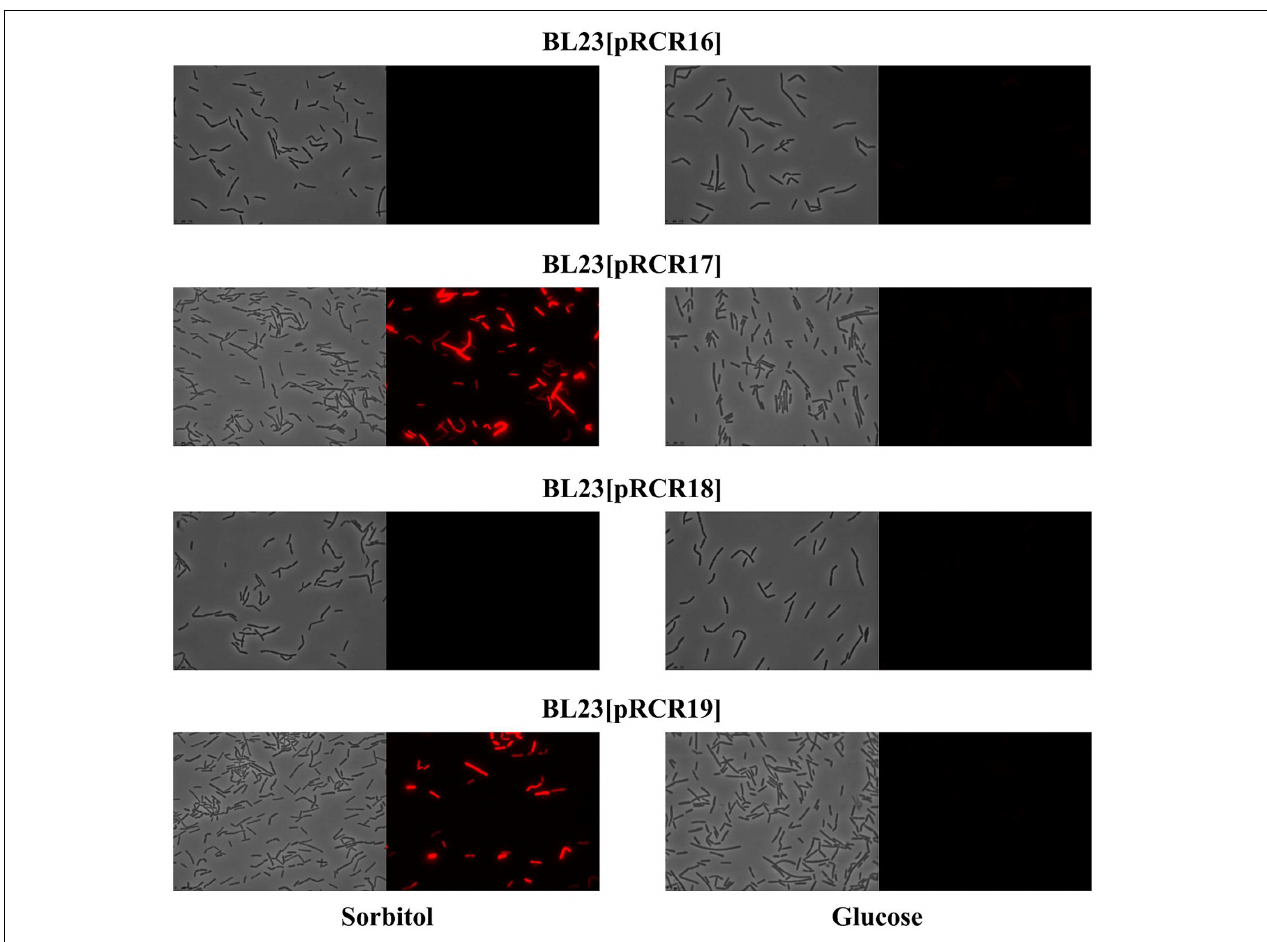
FIGURE 7 | Detection of fluorescence in L. casei BL23 strains at stationary phase. Cultures of the indicated strains in MRSS (sorbitol) or MRSG (glucose) were analyzed by phase contrast (left panels) or fluorescence (right panels)